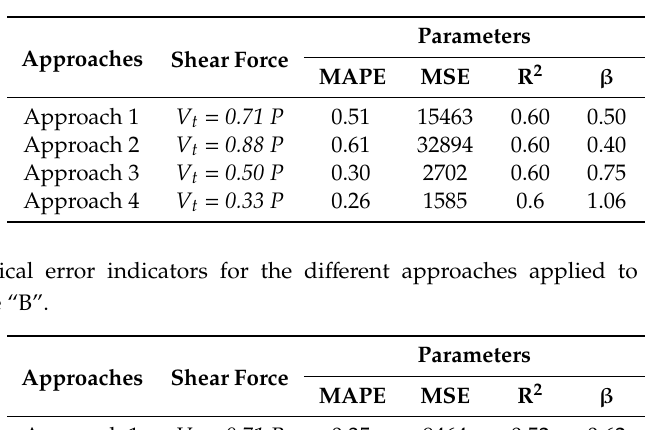
Statistical error indicators for the di ff erent approaches applied to the strengthened walls—procedure “A”.